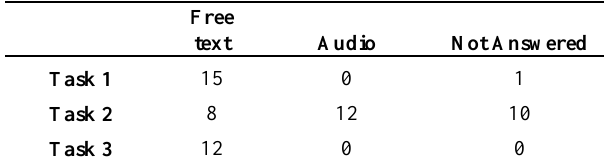
Table 7. Data entry method used by respondents.